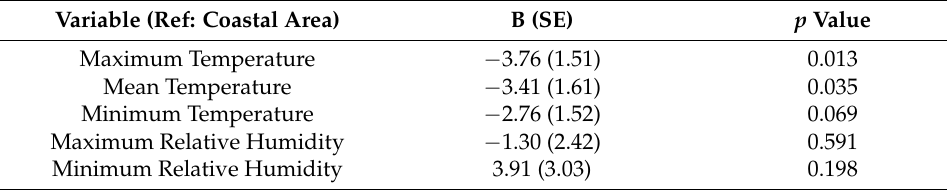
Table 2. Comparison of climatic conditions variables using Prais–Winsten regression between a coastal area in central Greece (Volos) and a mainland area in northern Greece (Naousa), from